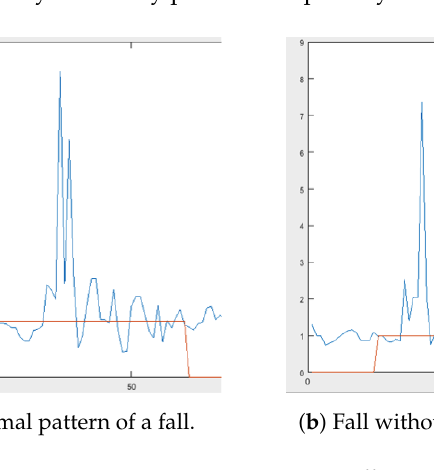
Figure 3. Different fall signal